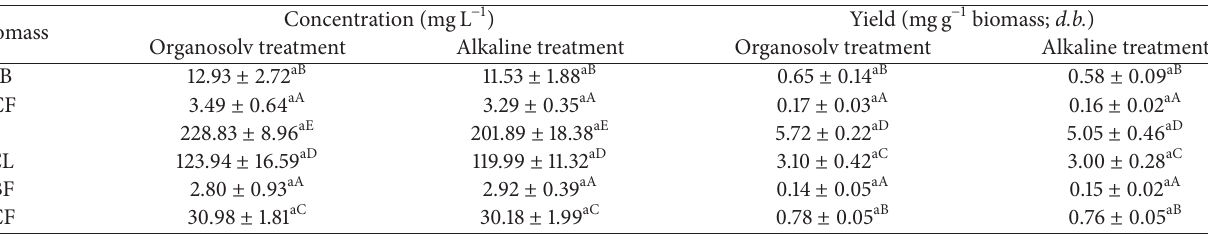
Table 3: Ferulic acid content in lignin-free liquor produced from six different biomasses through alkaline and organosolv treatment at 120 ∘ C for an hour ( 𝑛 = 3 ; 𝑃 < 0.05